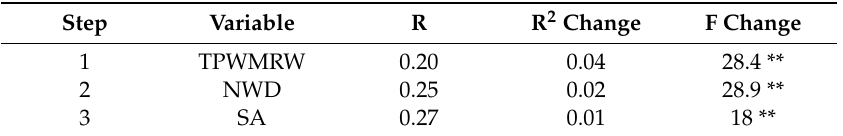
Table 4. Multiple regression